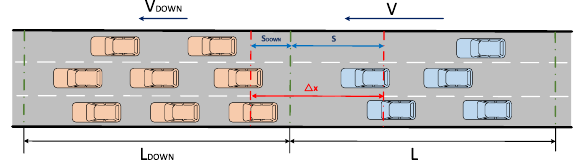
Figure 4. Time to the collision between two adjacent segments [34].